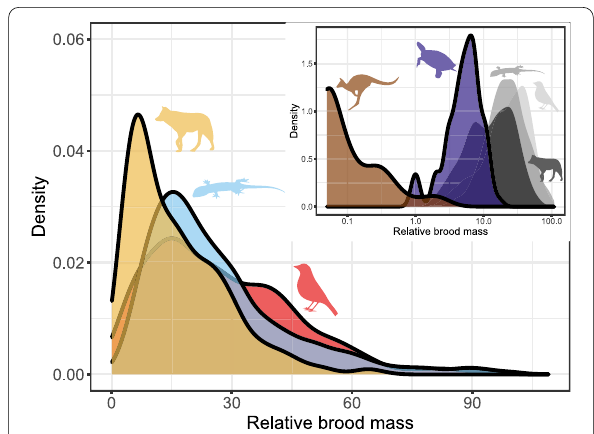
Fig. 9 Relative brood mass. Red: birds; blue: squamates; purple: turtles; yellow: placental mammals; brown: marsupial mammals. Note that the x axis in the inset figure is log 10 scaled